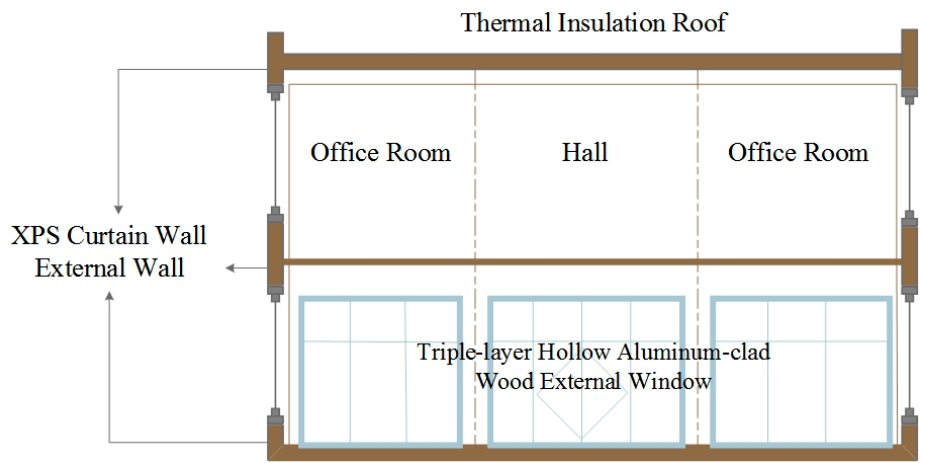
Figure 2. Side view of Senying passive office building.